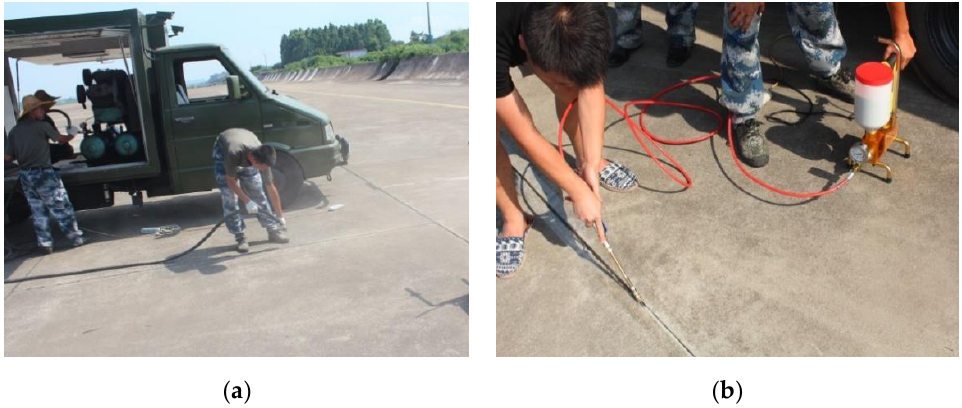
Figure 14. Brief application process. ( a ) Blowing joints by high pressure air gun. ( b ) Injecting the PCFC.